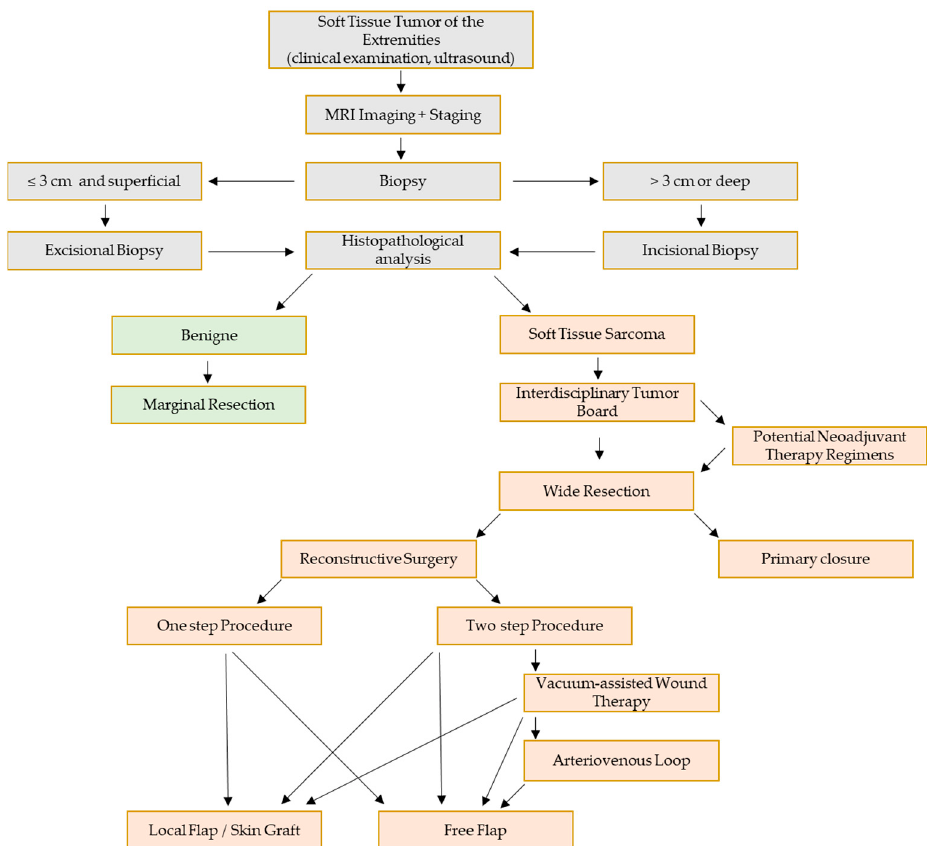
Figure 1. Proposed therapy algorithm for interdisciplinary surgical therapy of extremity soft-tissue sarcomas.